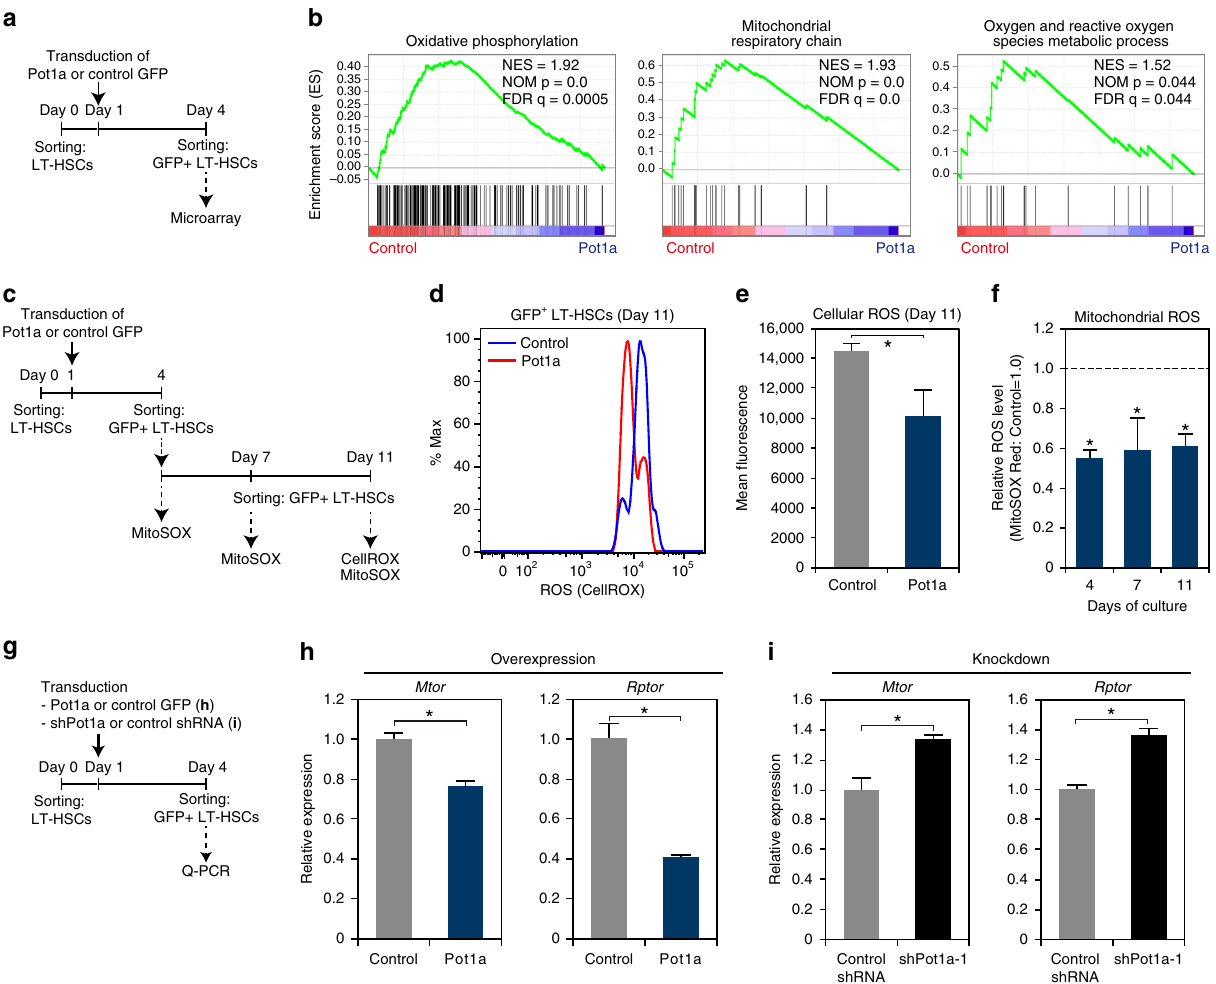
Fig. 5 Effect of exogenous Pot1a on ROS production in LT-HSCs in culture. a Schematic of the microarray analysis. b GSEA plots demonstrating enrichment levels of indicated gene sets in control control-GFP versus Pot1a-transduced LT-HSCs. NES, NOM p value, and FDR are indicated. c Schematic of the measurement of ROS in LT-HSCs. d Intracellular ROS levels in control-GFP ( blue ) and Pot1a-transduced ( red ) LT-HSCs. Representative FACS pro fi les of CellROX in GFP + LT-HSCs are shown. e Mean fl uorescence level. Data are expressed as the mean ± SD ( n = 5, * p < 0.01 by t -test). Representative data from two independent experiments are shown. f Relative mean fl uorescence level of MitoSOX in the GFP + LT-HSCs on days 4, 7, and 11 of culture. Mean fl uorescence level of MitoSOX in control-GFP-transduced LT-HSCs was set to 1.0. Data are expressed as the mean ± SD ( n = 6: day 7, n = 12: day 7, n = 3: day 11, * p < 0.01 by Tukey ’ s test). g Schematic of the measurement of ROS in LT-HSCs upon overexpression or knockdown of Pot1a. h Expression of Mtor and Rptor in Pot1a-overexpressing LT-HSCs. Data are expressed as the mean ± SD ( n = 4, * p < 0.01 by t -test). i Expression of Mtor and Rptor in Pot1a knockdown LT-HSCs. Data are expressed as the mean ± SD ( n = 4, * p < 0.01 by t